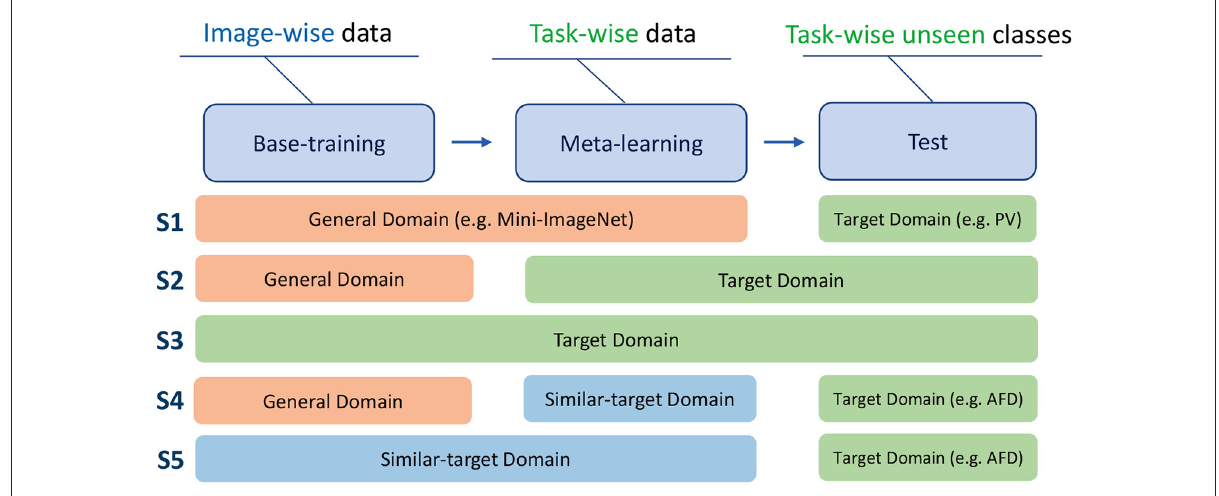
FIGURE4 The data formats used in base-training, meta-learning, and test. The five training